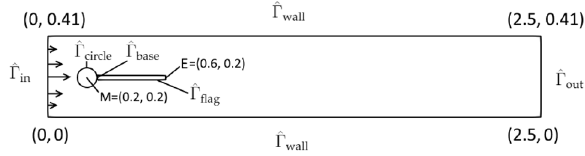
Fig. 5 Sketch of the domain and boundaries for the FSI bench- marks